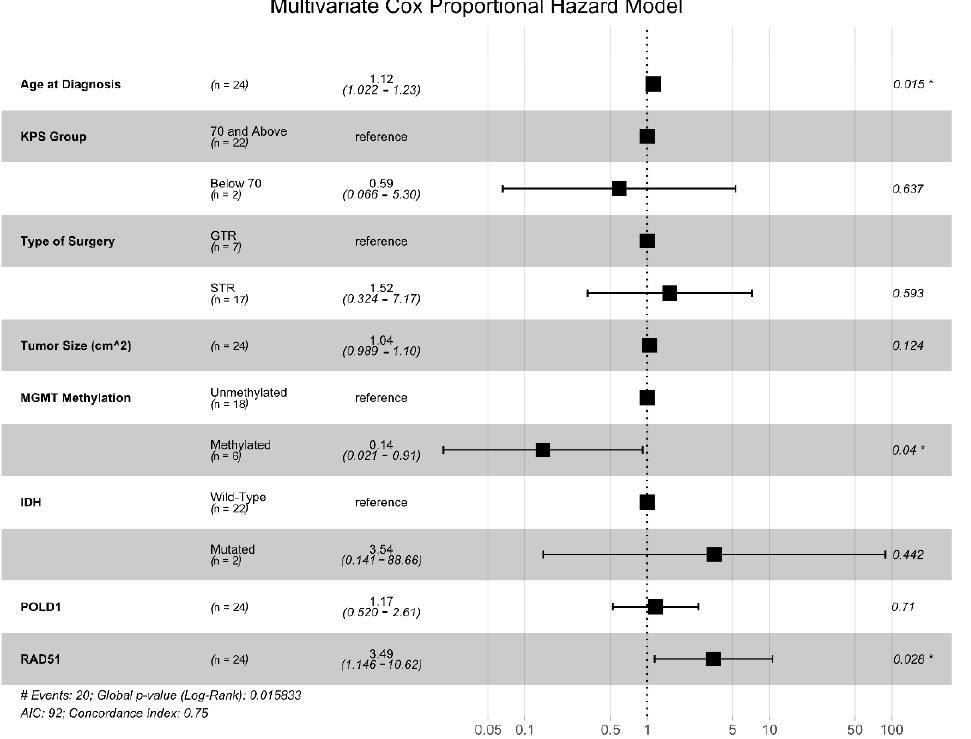
Figure 2. Multivariate Cox proportional hazards (CPH) model for OS. Multivariate CPH model including known clinical and genetic prognostic factors, as well as the seven DNA damage repair genes with at least a 4-fold differential expression and an adjusted p < 0.01 in the GBM vs. non- neoplastic comparison. * denotes variables with p values < 0.05.